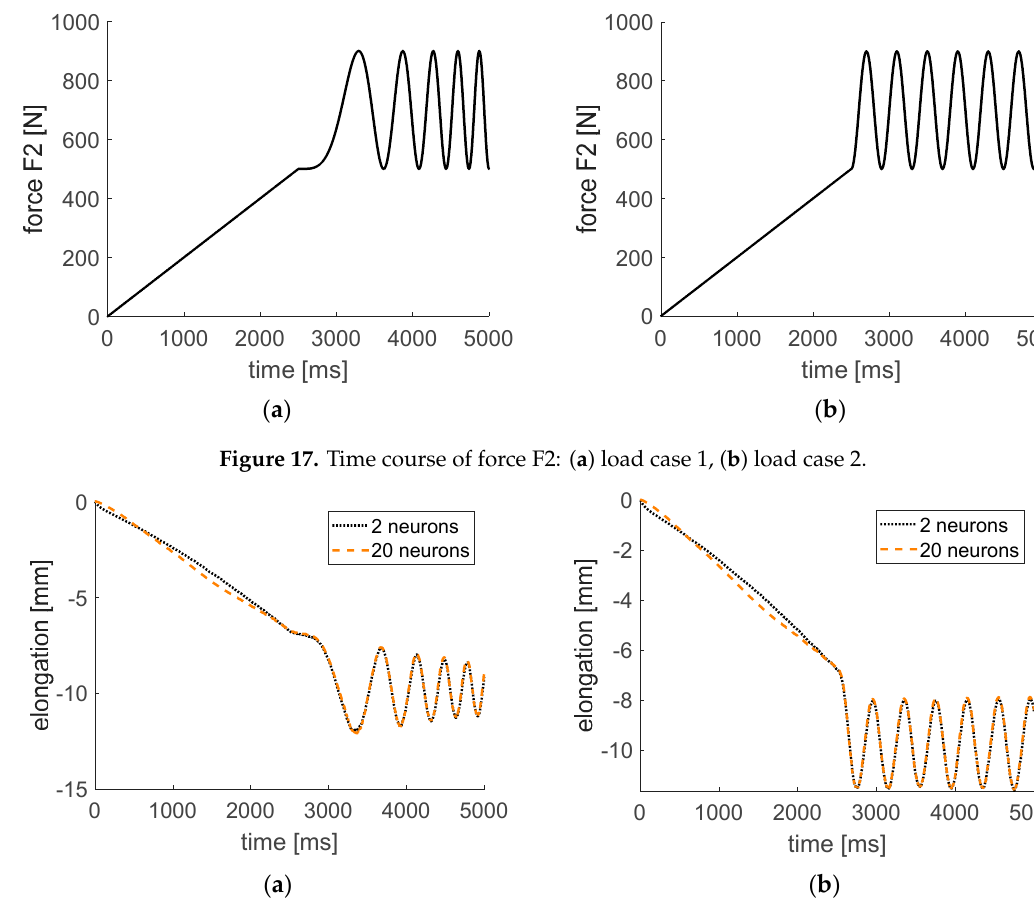
Figure 18. Elongation of the shock absorber: ( a ) load case 1, ( b ) load case 2.